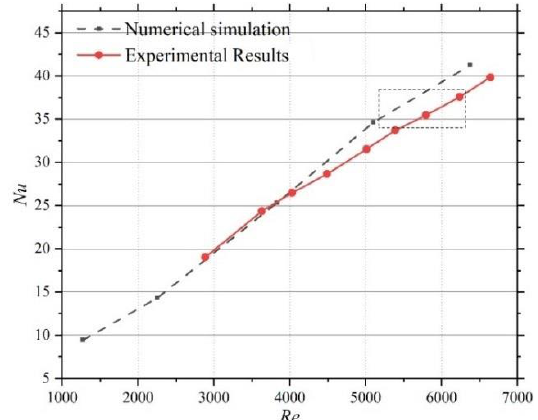
Figure 3. Numerical model validation (Experimental Results [10]).